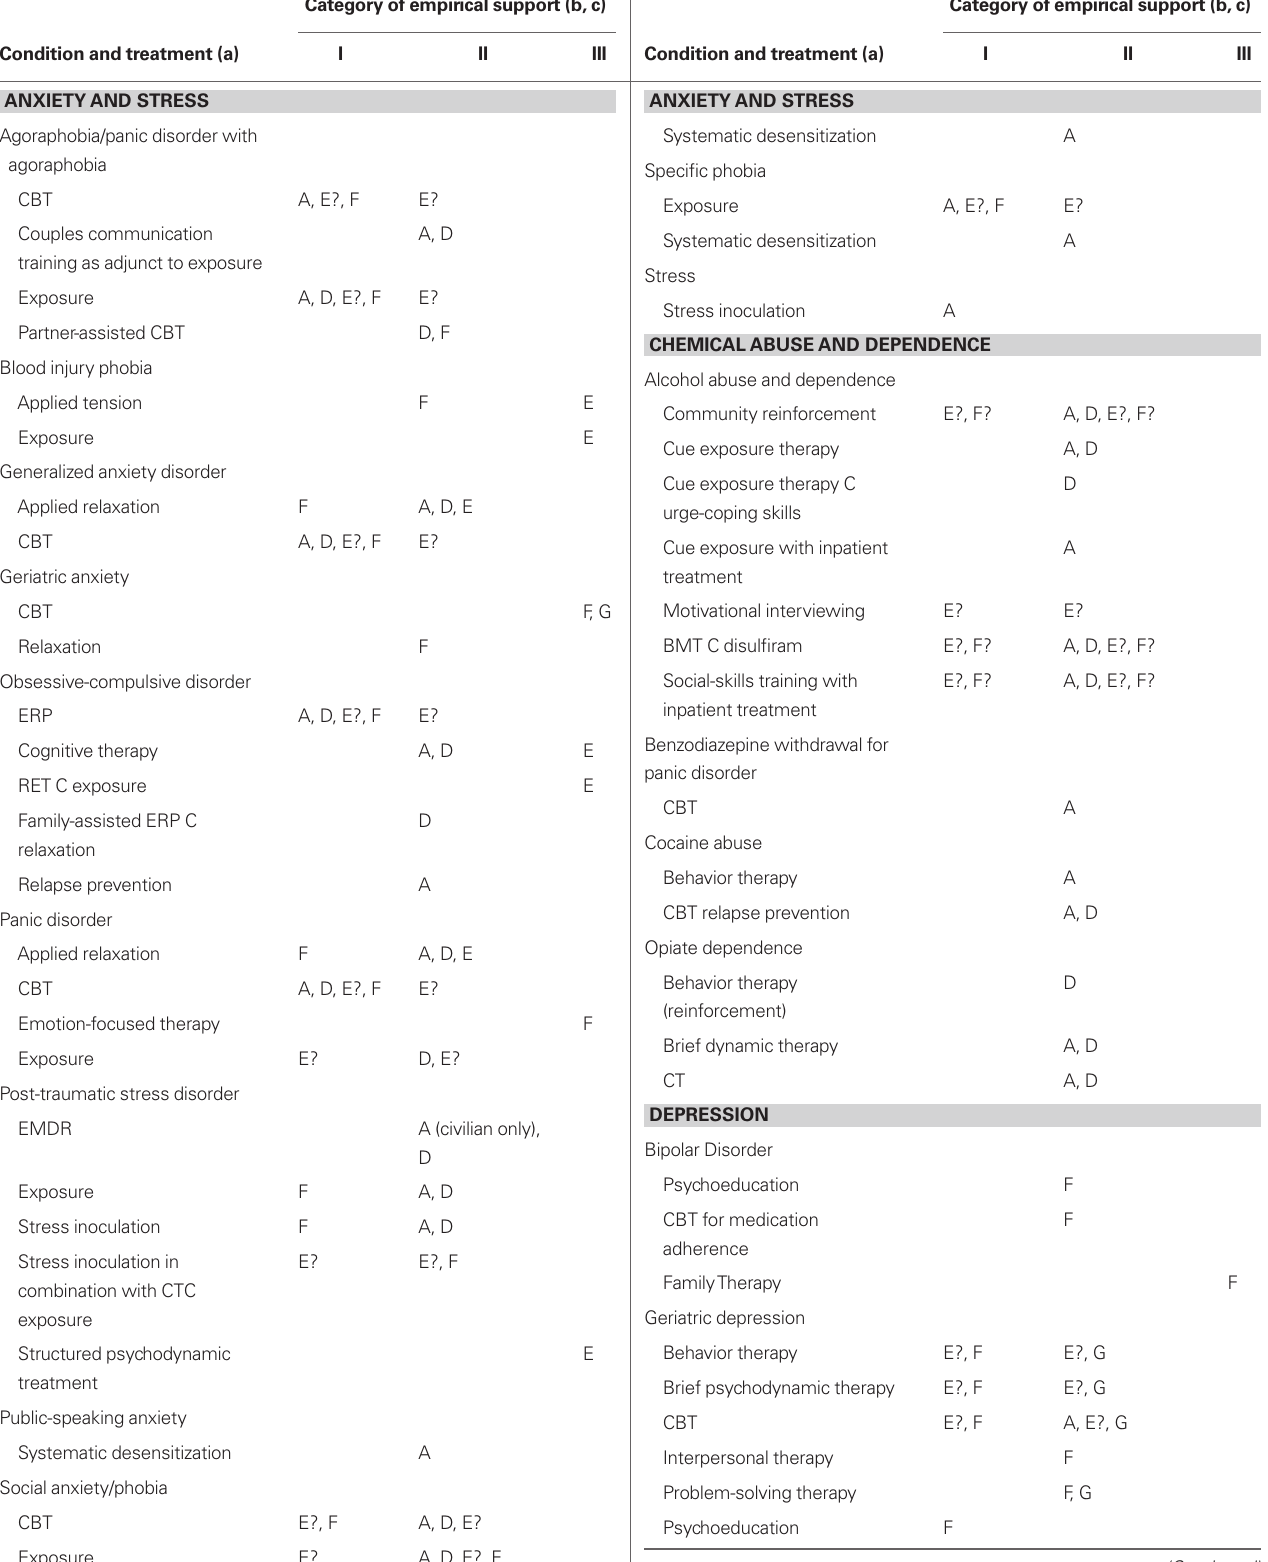
Table 3 | empirically supported treatments for adults: a summary across workgroups (source: Chambless and ollendick, 2001). Category of empirical support (b,